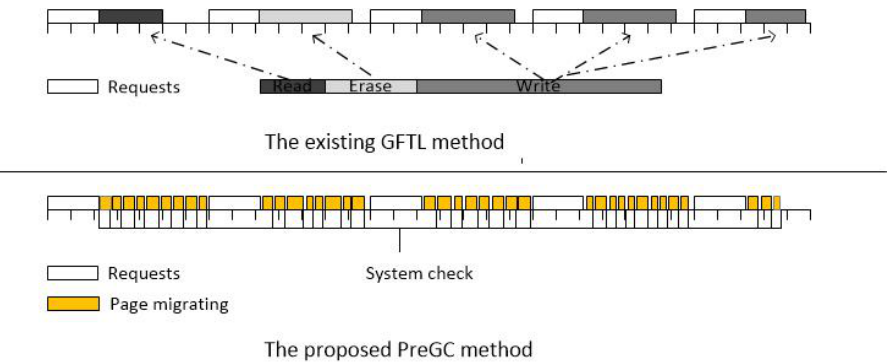
Figure 8. Comparison of two methods. The box in the figure represents the non-idle system state, and different colors indicate different states. The upper side of the figure shows the existing GFTL method, while the lower side shows the PreGC method proposed in this